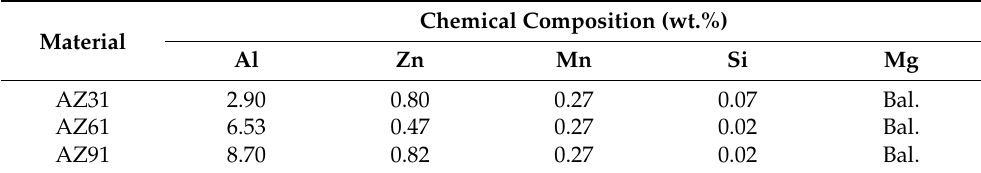
Table 1. Chemical composition of AZ31, AZ61, and AZ91 alloys.